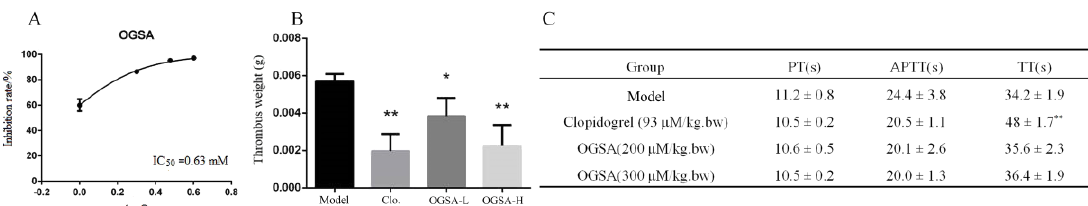
Figure 4. Evaluation of antiplatelet activity and side effects of OGSA. ( A ) Inhibition rate of OGSA on ADP-induced platelet aggregation in vitro. ( B ) The inhibitory effect of OGSA (200 and 300 µ M/kg.bw) and the positive control Clopidogrel (93 µ M/kg bw) on thrombus formation in vivo. ( C ) Effects of OGSA on PT, APTT, and TT in coagulation function test. Mean ± SD, n = 5, * p < 0.05, ** p < 0.01, ANOVA, compared with the model